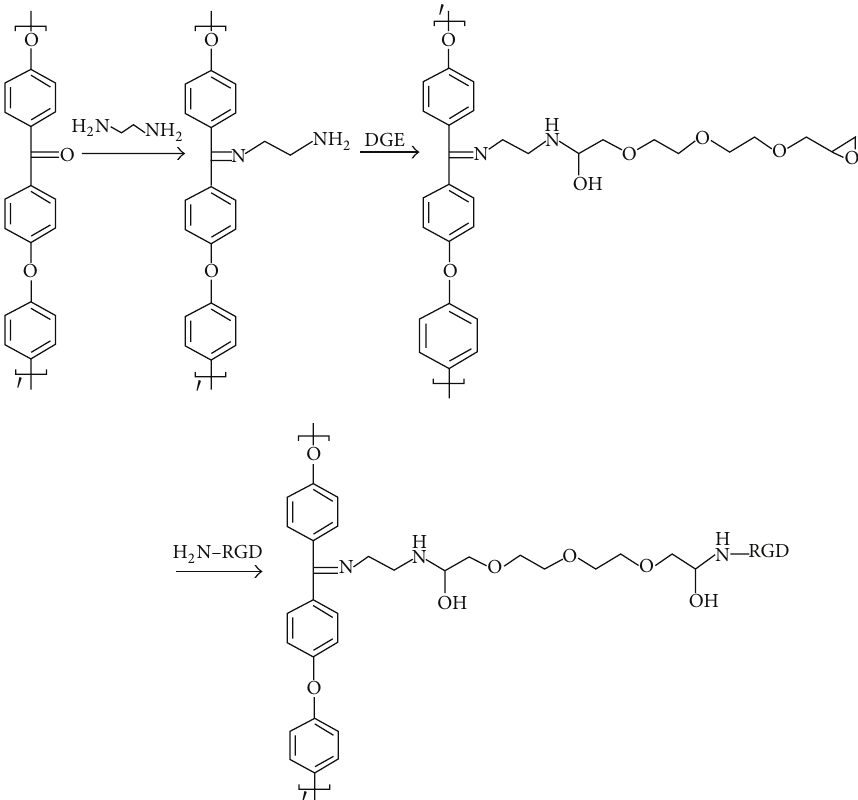
Figure 1: Reaction scheme for the cell-adhesive modification of PEEK. Surface activation was achieved via Schiff base formation using a diamine. Subsequent coupling of a diepoxide crosslinker afforded the covalent conjugation of the